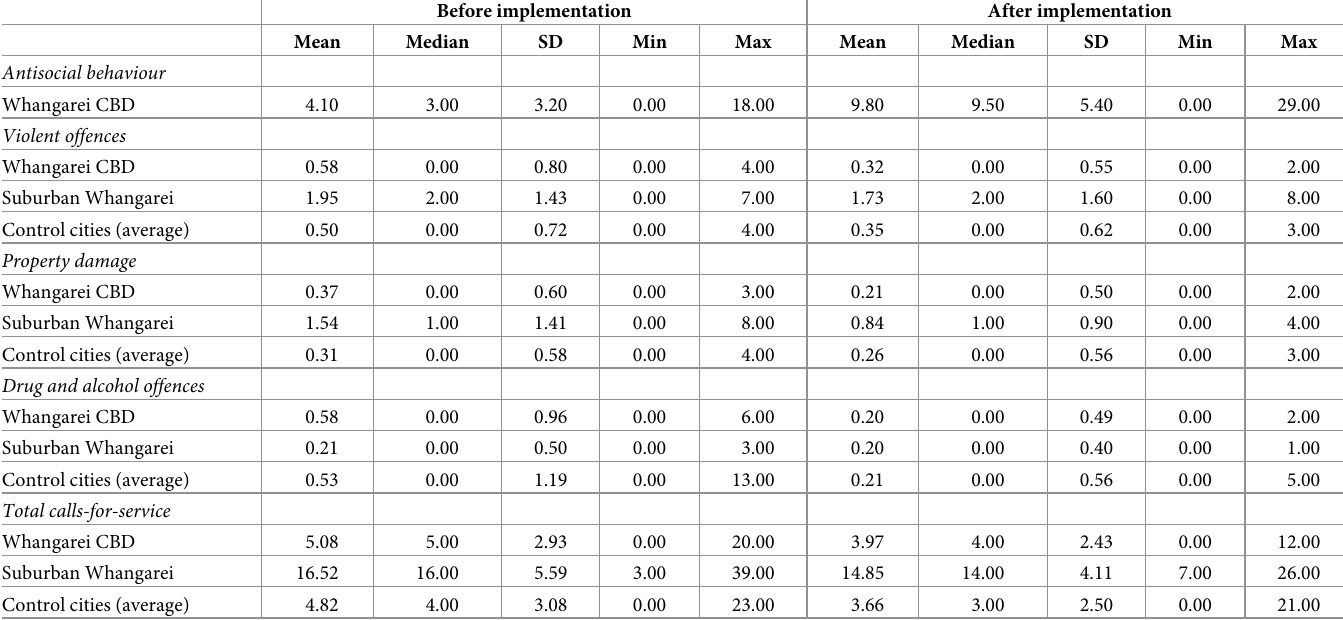
Table 1. Summary